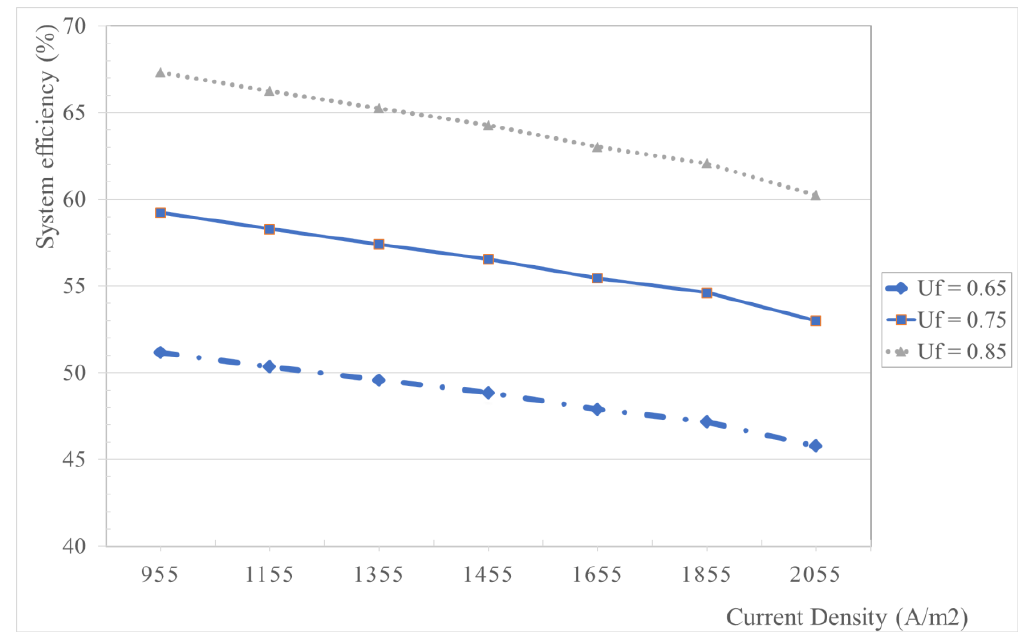
Figure 9. Effect of fuel utilization factor on the integrated system